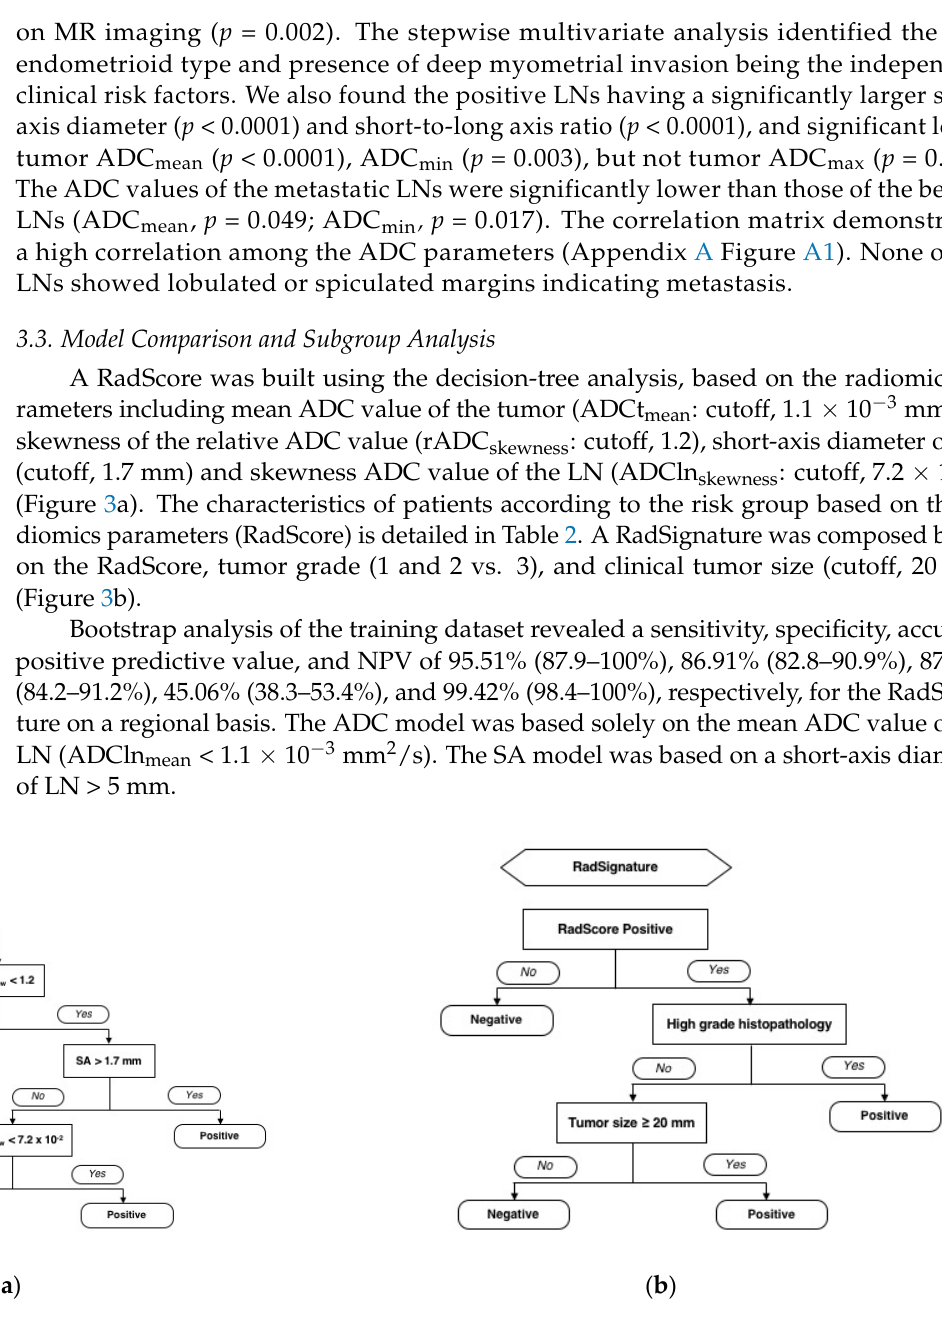
Table 2. Characteristics of patients according to the risk group based on radiomics parameters (RadScore).